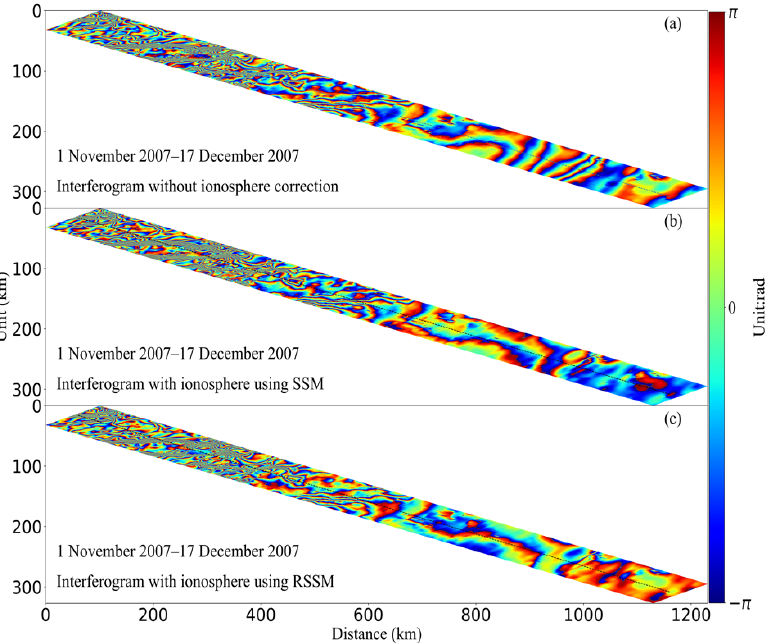
Figure 5. ALOS PALSAR images’ ionospheric correction results. ( a ) Interferogram without iono- spheric correction. ( b ) Interferogram with ionospheric correction using SSM. ( c ) Interferogram with ionospheric correction using RSSM. We can distinguish phases related to ice motion and the iono- sphere from Figure 5a,b.